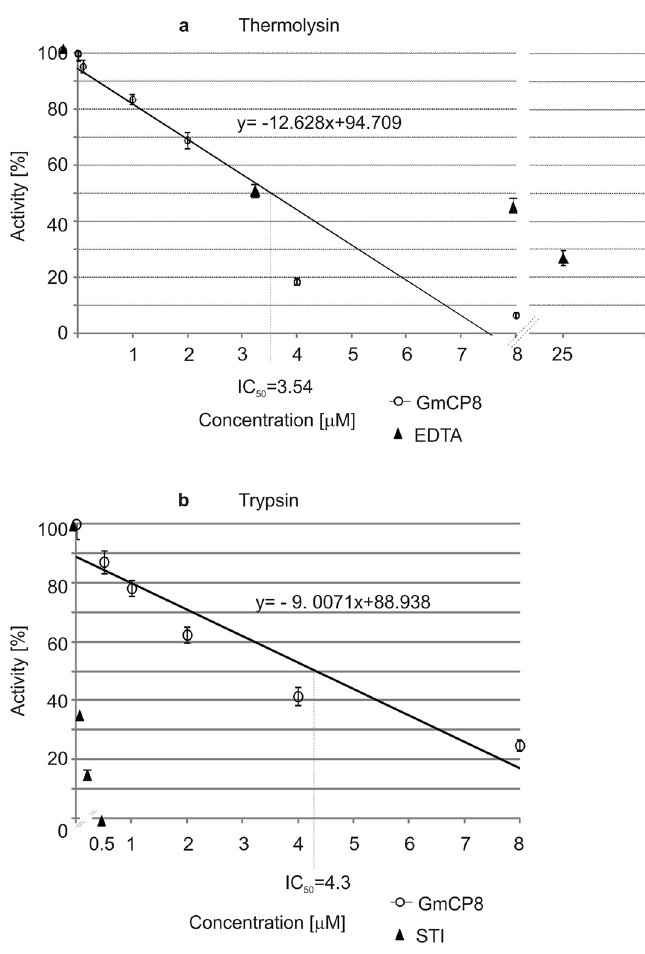
Figure 5. Effect of different concentrations of GmCP8 on the activity of: ( a ) thermolysin; ( b ) trypsin. The results show the mean values from three assays ± SD. EDTA ( a ) and STI ( b ) were used as positive controls and are shown as points. In ( b ), the values for STI between 0 and 0.5 µM are 0.05 and 0.1, which is not shown on the X axis to keep the graph readable. The results obtained for GmCP8 are shown together with trend lines. The IC 50 of GmCP8 were calculated from the formulas of the respective lines. The control group (100% relative activity) contained water instead of the